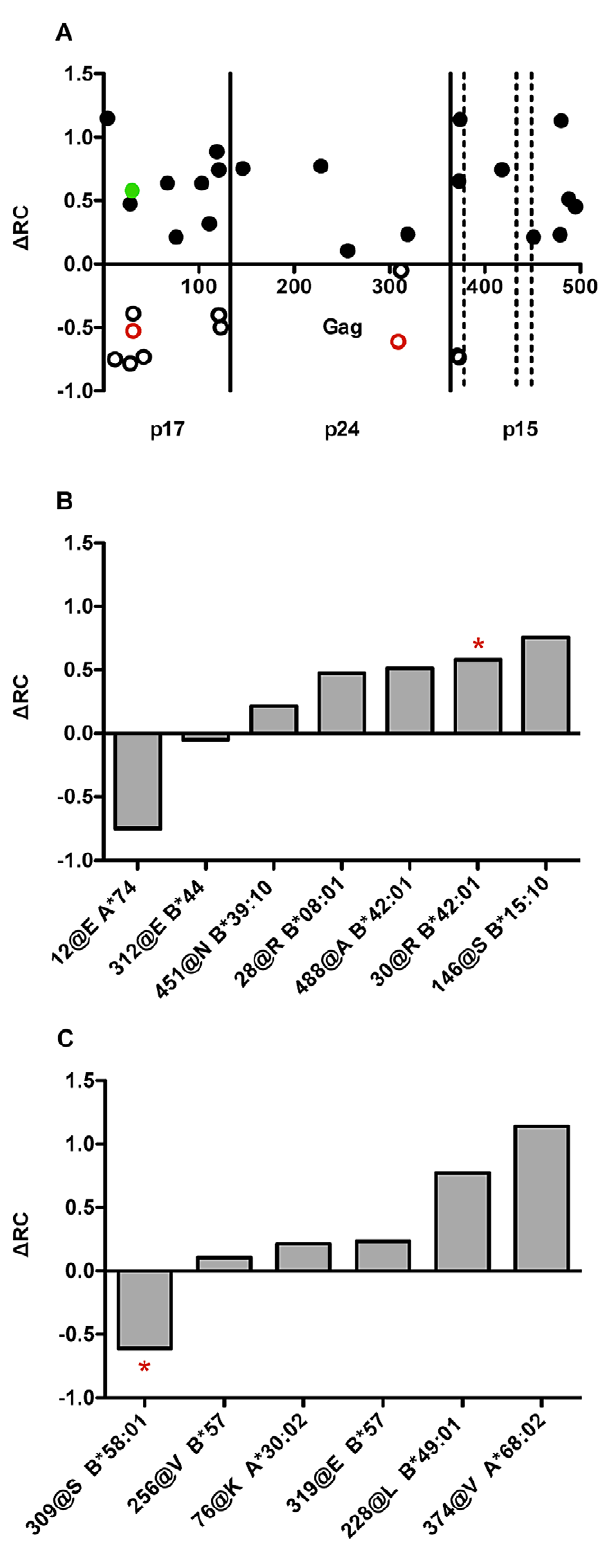
Figure 3. Identification of polymorphisms in Gag that signif- icantly affect RC, several of which can be linked to HLA-class I alleles. (A) In a pair-wise analysis of all amino acids represented in the 149 gag sequences tested, we observed 49 amino acids at 31 unique positions that were statistically associated (p , 0.05) with changes in